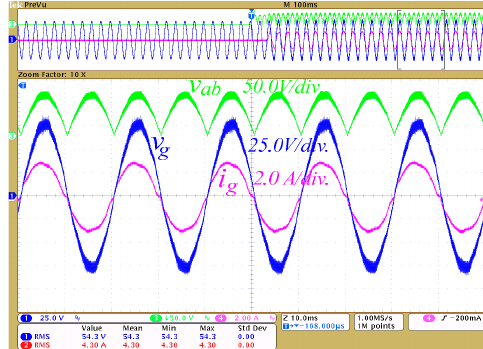
Figure 12. Experimental results of the grid-connected converter in the inverter mode.